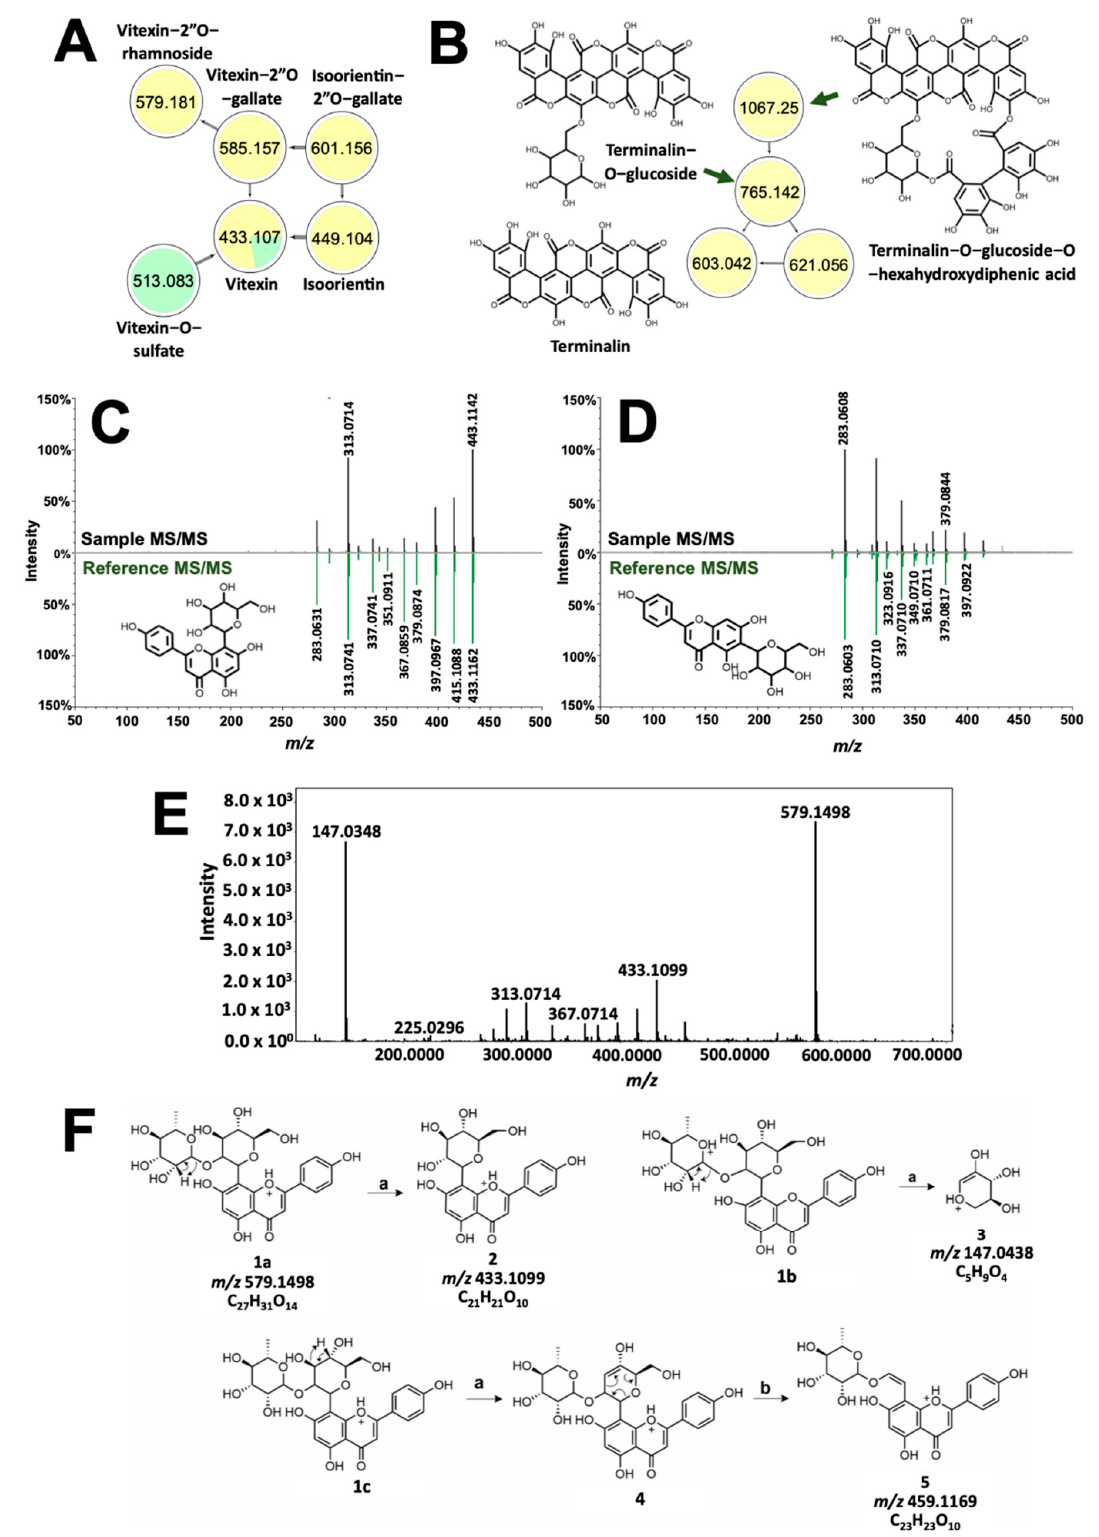
Figure 6. Structural analysis of dye molecules common to T. catappa and D. philippinensis. Molecular network of flavotannins and ellagitannins are depicted in ( A ) and (B), respectively. GNPS also differentiated positional isomers vitexin ( C ) and isovitexin ( D ). Meanwhile, tandem MS spectrum of m/z 579.1496 showed huge similarity with that of vitexin ( E ). Fragmentation analysis suggest the presence of rhamnosyl substituent at C2 ′ ’ of vitexin ( F ). For the reactions, ( a ) is the remote H-rearrangement, and ( b ) is the RDA reaction.